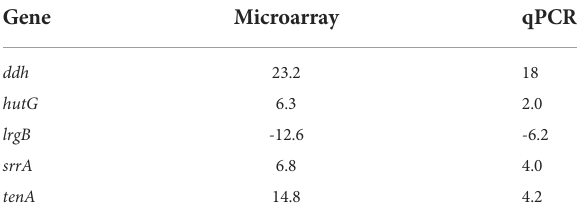
TABLE 5 Correlation of microarray data with quantitative Real-time PCR (qPCR, fold change). Gene